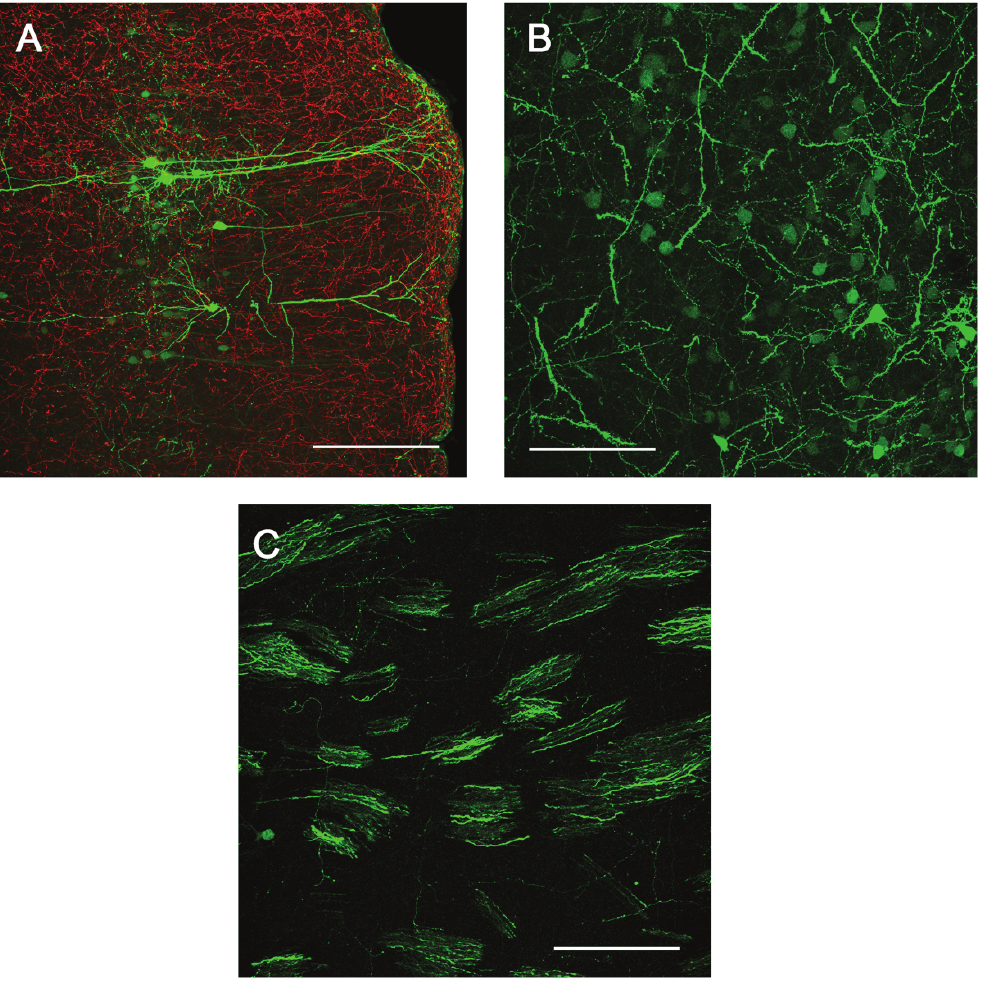
Figure 6. Sites of presynaptic GFP expression resulting from stereotactic delivery of Ad5-CGW-CK2 to SN. Regions with afferent projections to the SNc showed large numbers of neurons infected by Ad5-CGW-CK2. Regions presynaptic to the site of injection, including pyramidal neurons of the lateral cortex ( A ) and neurons of the globus pallidus ( B ), showed robust GFP expression. Additionally, GFP-positive fibers could be traced coursing through the STR in bundled myelinated fibers ( C , correlating to the human internal capsule). All images are flattened confocal z-stacks through the regions